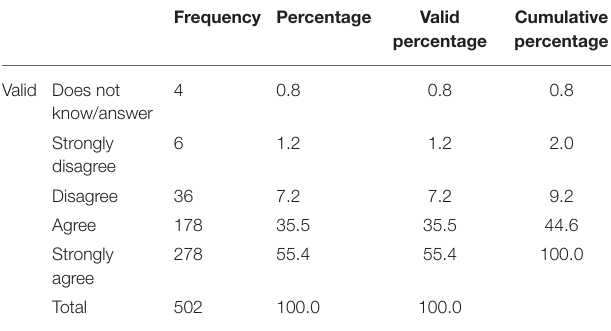
TABLE 5 | Item 16. Argumentation serves to express one’s position on an issue.